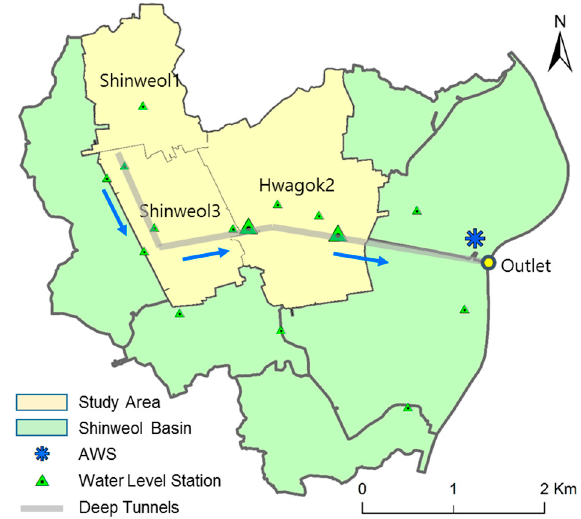
Figure 1. Study area in Shinweol Basin, Seoul, South Korea. Precipitation data with 10-min time intervals obtained from the Automated Weather System (AWS) in the basin.